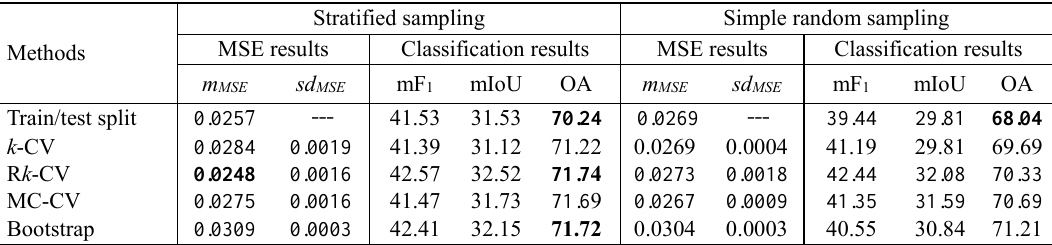
Table 3. Results based on train/test split and resampling methods ( k -CV, R k -CV, MC-CV and bootstrap). Outcomes reveal impact on error metrics, and classification performance metrics (in %) for the ISPRS benchmark Vaihingen test data set (Scene 1 and